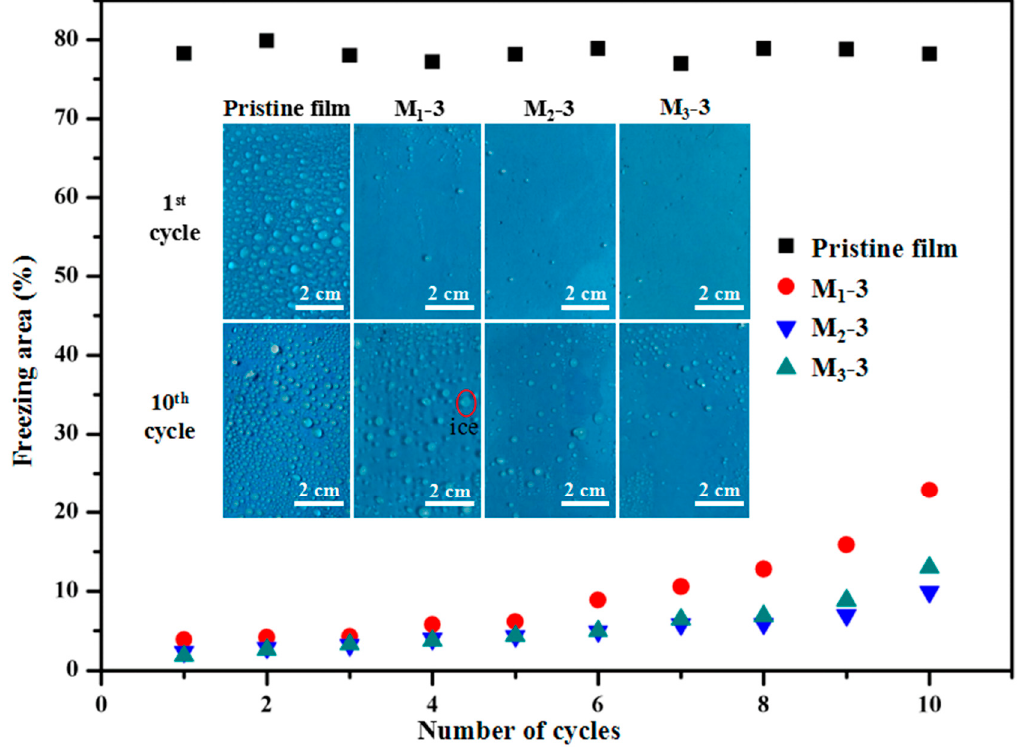
Figure 10. The freezing area ratio on shrinking pristine HSPVC film and shrinking PTFE/HSPVC composite films in the ten cycles of icing and deicing. The illustration corresponds to digital photos of shrinking pristine film, M 1 -3, M 2 -3, and M 3 -3.